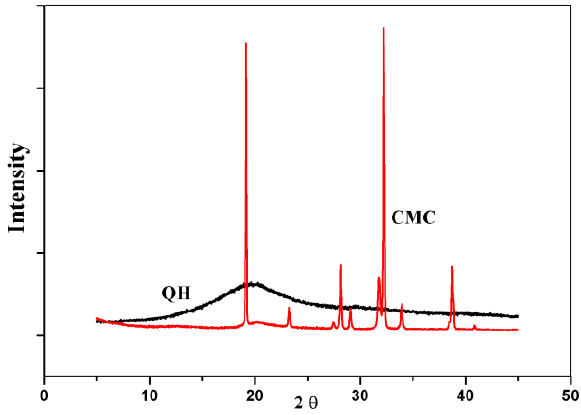
Figure 3. The XRD patterns of QH and CMC.